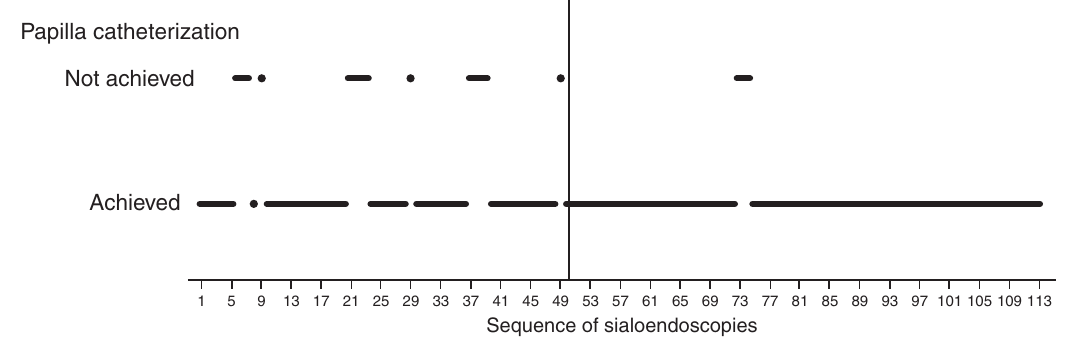
Figure 3 Sequence chart of 113 consecutive sialendoscopies. Black points at lower horizontal position represent procedures in which papilla catheterization was achieved, while those at upper position represent failure to achieve it. Vertical dashed line marks the 50th procedure.